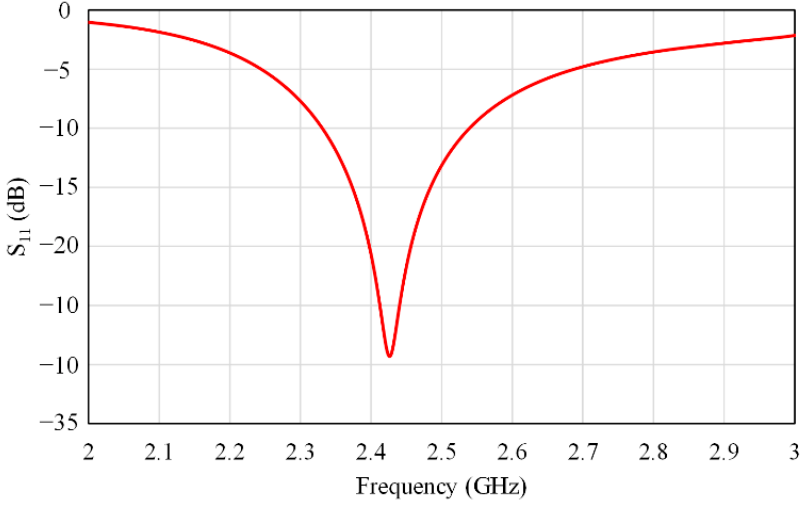
Figure 16. The simulated S 11 of the modified single band antenna.